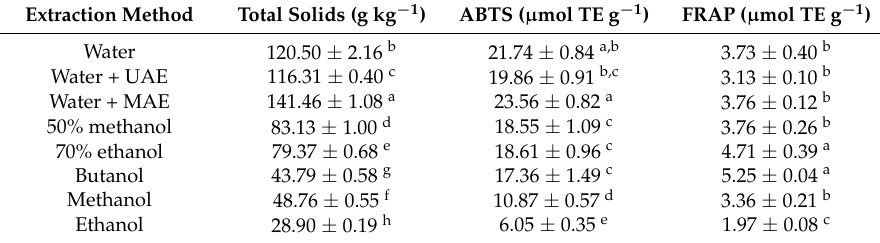
Table 2. Effect of extraction method on total solids and antioxidant capacity of defatted Gac seed powder.